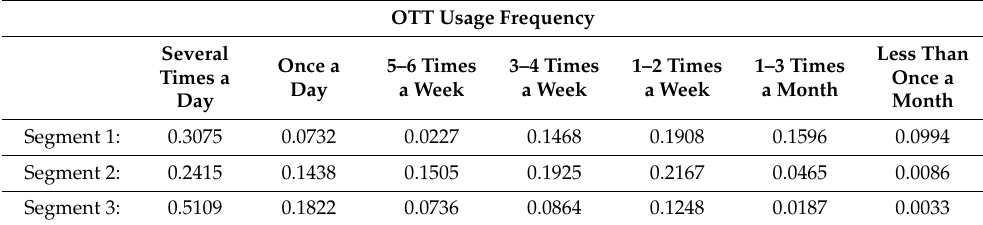
Table 4. Item-response probability by OTT usage